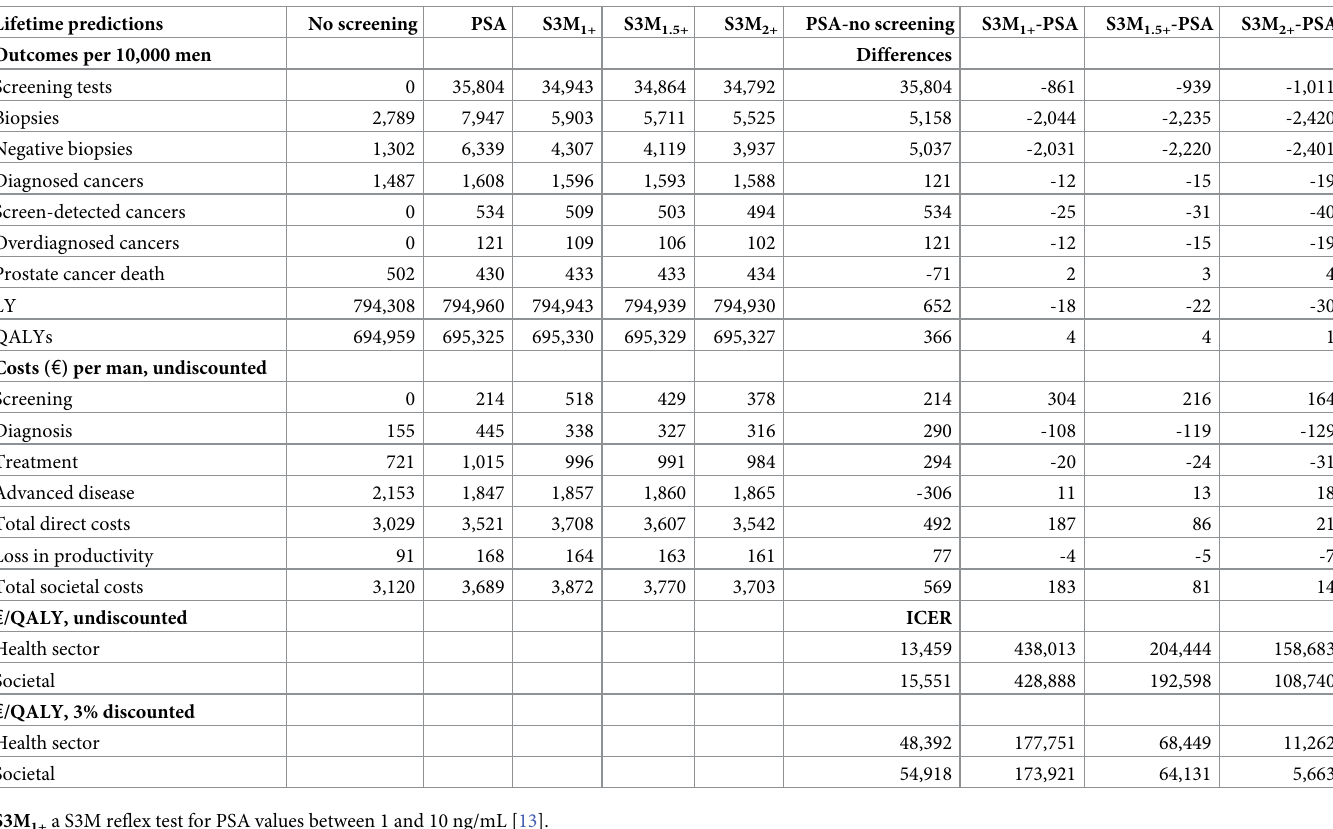
Table 2. Predicted effects for no screening, PSA screening and S3M screening at 4-year intervals for the ages 55 to 69 years. The effects are presented as clinical events per 10,000 men, cost as Euros per man and cost-effectiveness as € /QALY. The four right most columns contrasts the clinical and costs as differences and cost-effectiveness as incremental cost-effectiveness